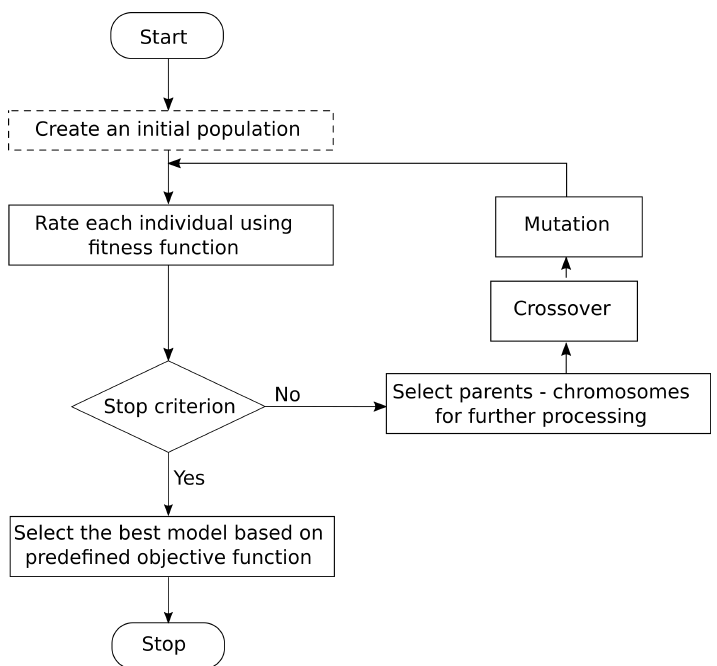
Figure 3. Regularization genetic algorithm